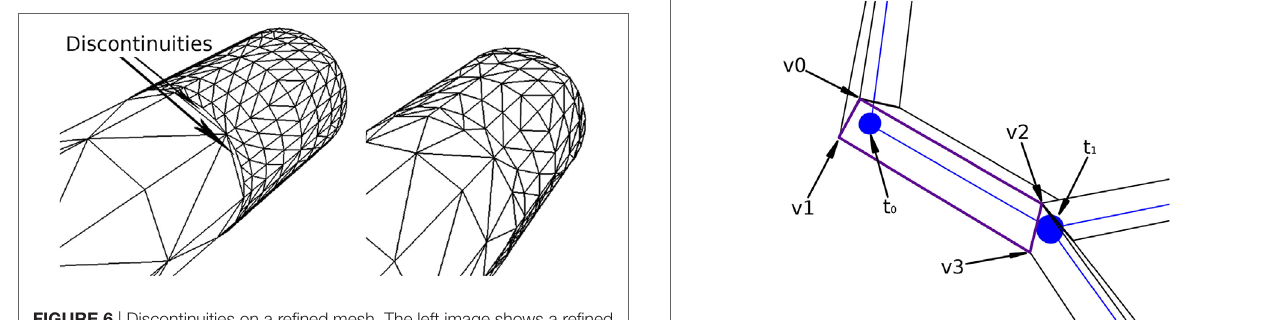
FIGURe 6 | Discontinuities on a refined mesh. The left image shows a refined mesh with discontinuities caused by the difference in contiguous subdivision levels. The right image shows the same mesh refined with our method, in which there are no discontinuities.